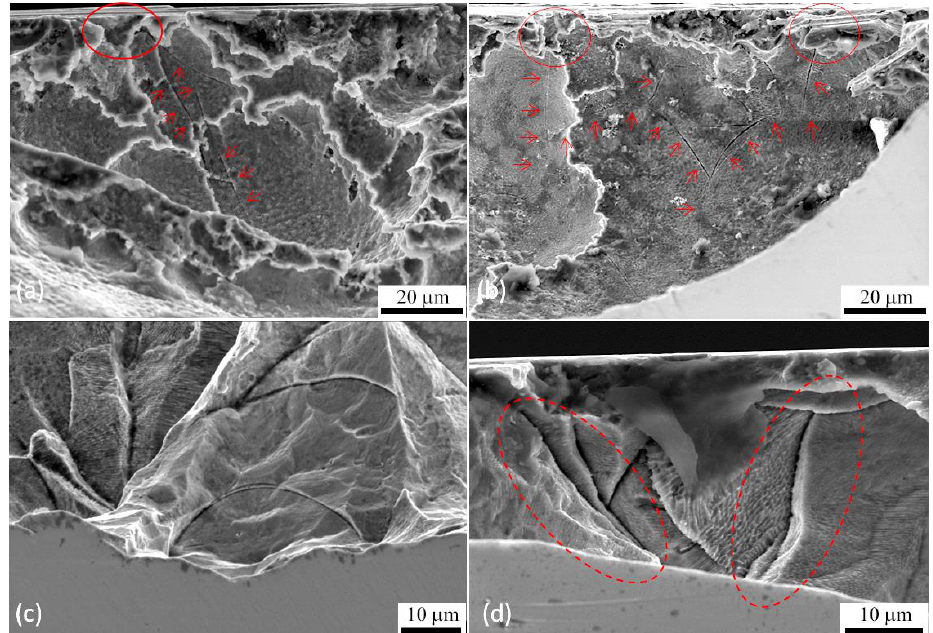
Figure 11. SEM Images of specimens with 310 MPa RS magnitude at different immersion times and magnifications ( a ) after 150 s showing the initiation of the crack from surface pits shown in red circle and crack initiation shown with red arrows ( b ) after 400 s with the evidence of stress corrosion cracking (SCC) propagation along the melt pool boundaries and dominant surface pores and pits as precursors for SCC initiation shown in red arrows ( c , d ) crack propagation in early stages of corrosion attack on the surface with higher magnification showing selective corrosion and SCC attack along the columnar grains and melt pool boundaries which is shown in elliptical red